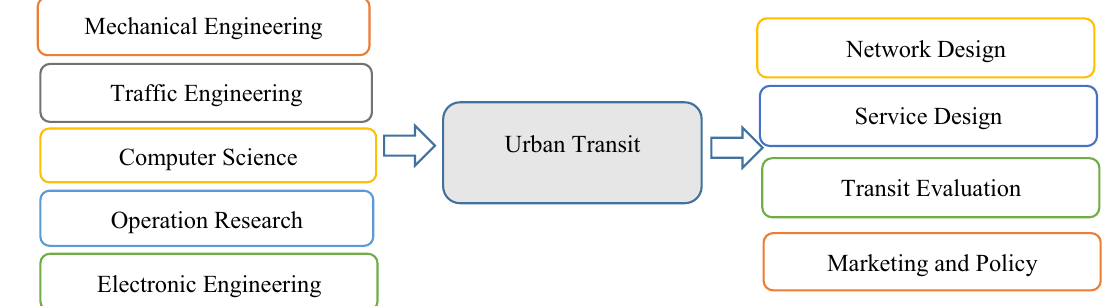
Fig. 1 Integrated framework of related subjects and topic in urban transit